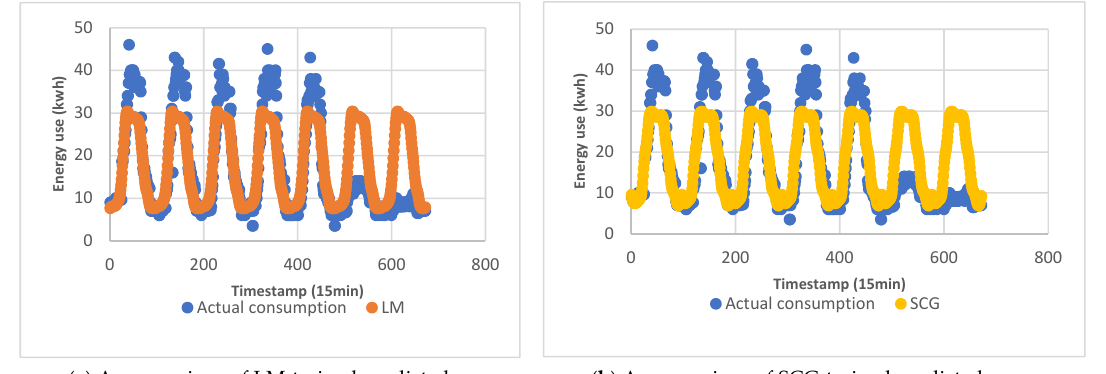
( a ) A comparison of LM-trained predicted energy usage to the actual energy use of the first week of the forecasted autumn period.